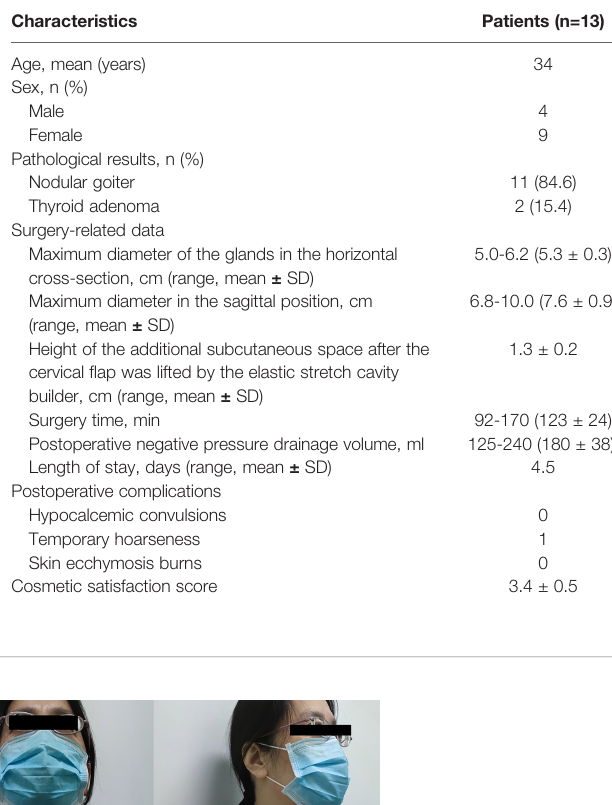
TABLE 1 | Baseline features, surgical data, and postoperative data.